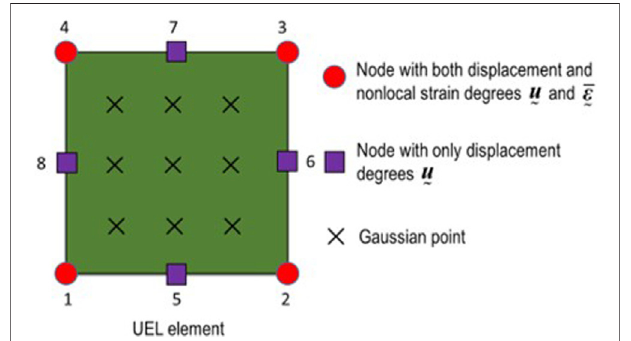
FIGURE2| Degreesoffreedom of2Delement fortheGED-MPSmodel.